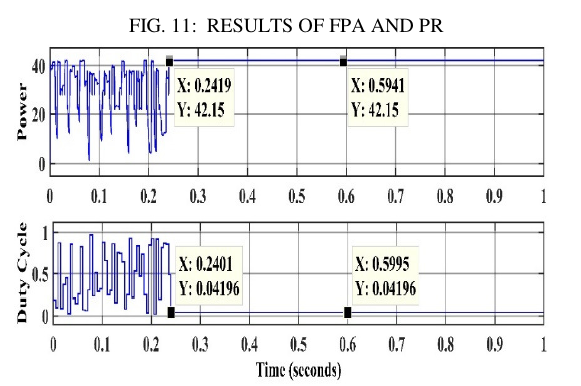
FIG. 11: RESULTS OF FPA AND PR